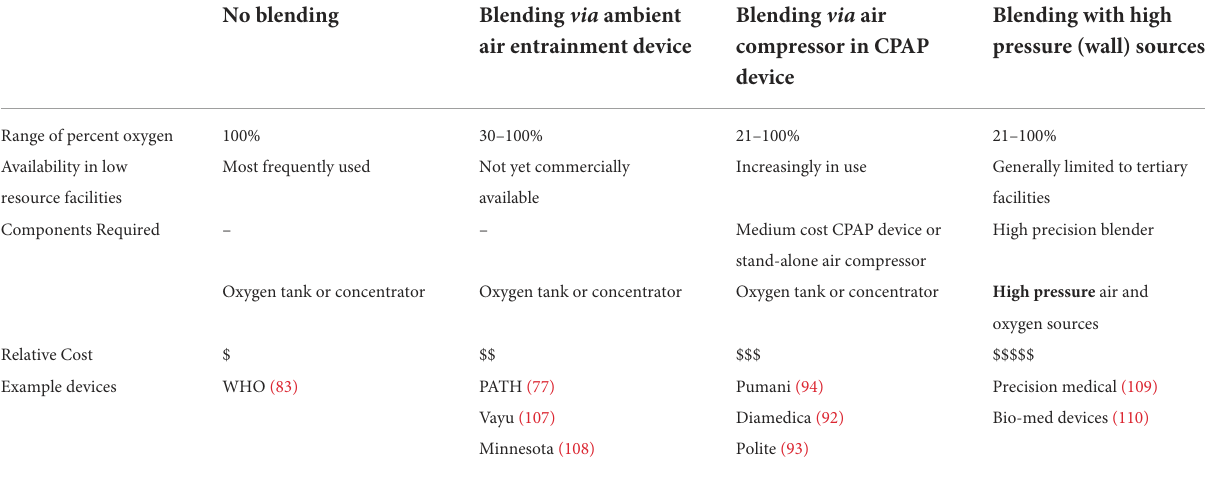
TABLE 3 Oxygen blending modalities for CPAP in low resource